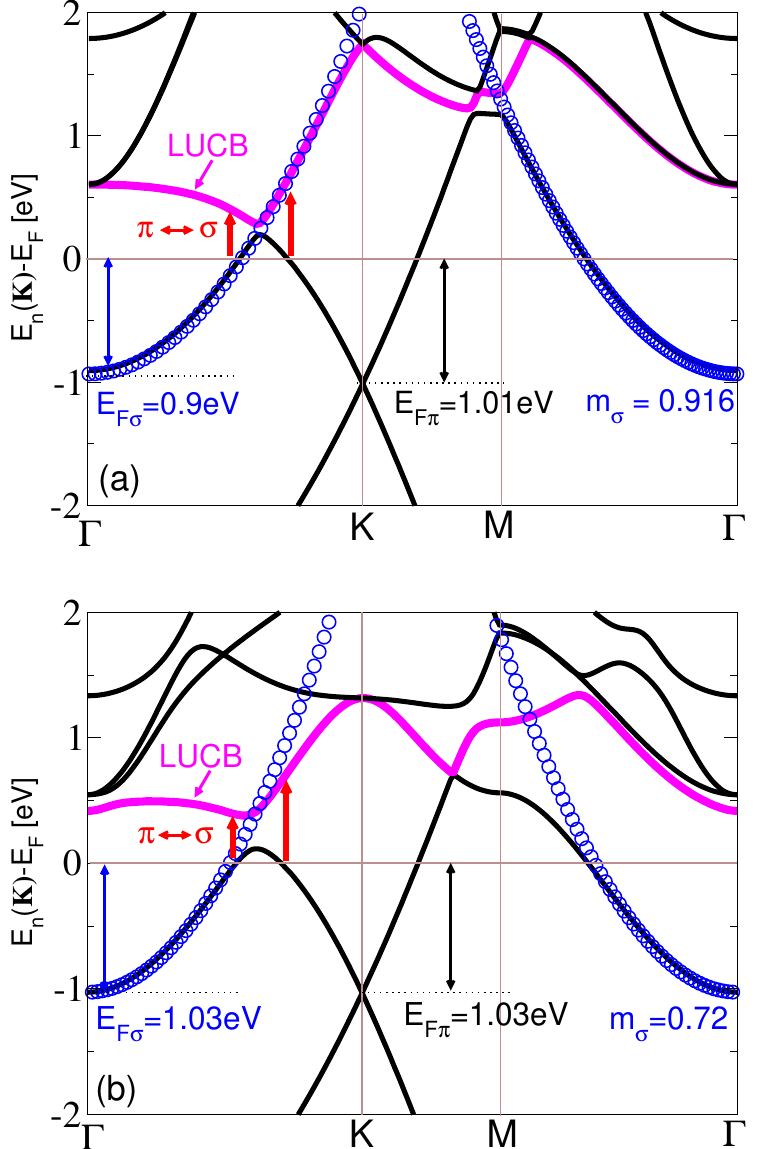
Figure 4. The electronic band structure in ( a ) KC 8 and in ( b ) CsC 8 . The magenta line denotes the lowest unoccupied band (LUCB). The blue circles represent the parabolic fit E ( K ) = E F σ + ¯ h 2 K 2 the alkali atom σ